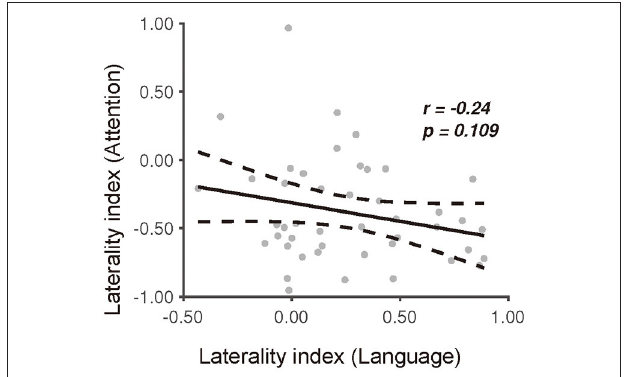
FIGURE 6 | The relationship between the picture-naming and landmark task in terms of the degree of laterality index. Dissociation of the laterality index between the picture-naming task and the landmark